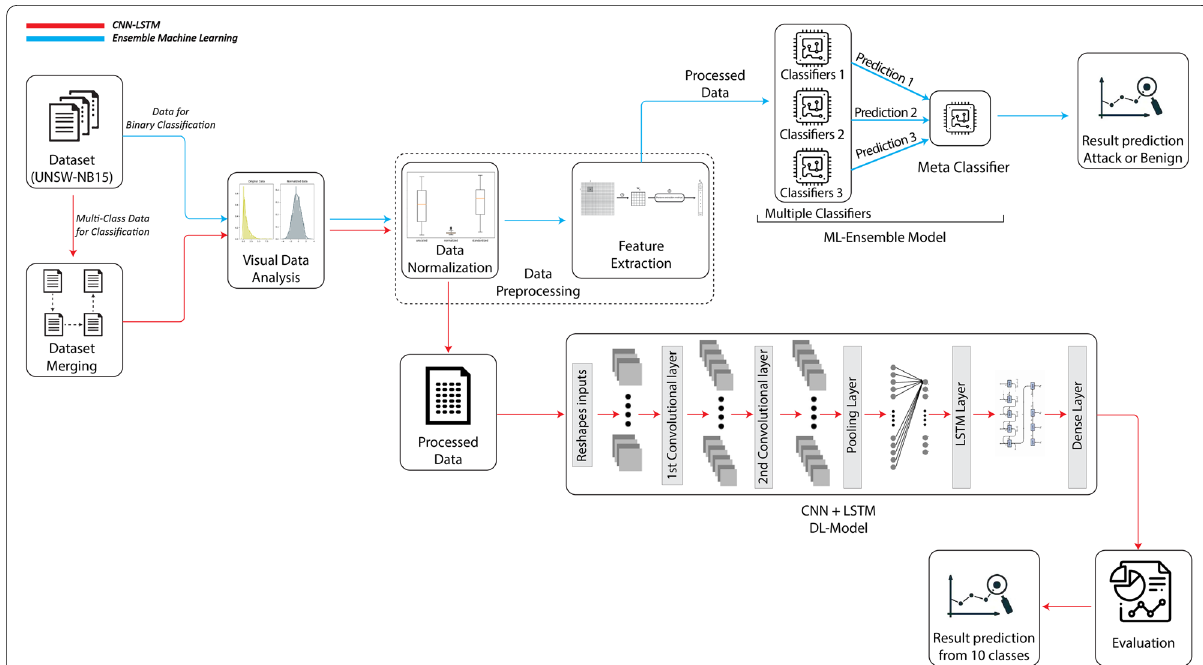
Fig. 1 Workflow Model Depiction of Proposed Approach for Network Graph Data based Anomalies